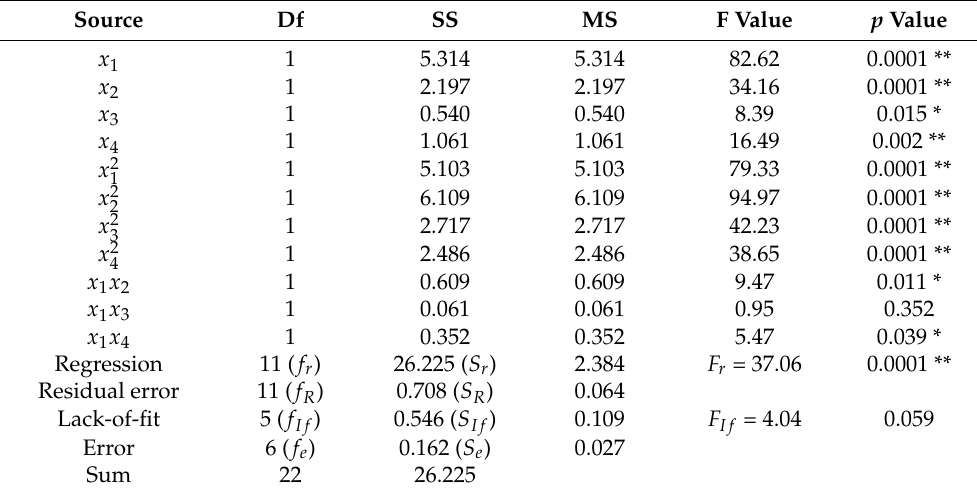
Table 4. Analysis of variance for the regression